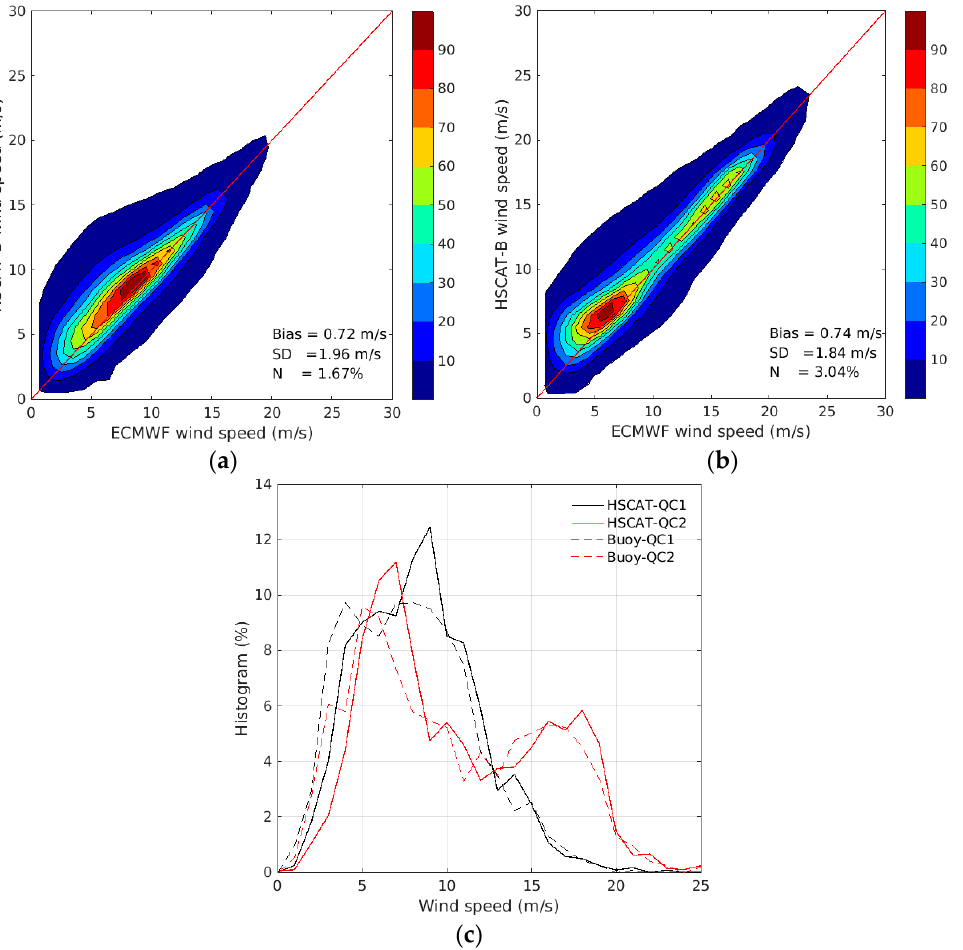
Figure 6. 2-D histograms of HSCAT-B winds rejected by the MLE m QC but preserved by the MLE QC (i.e., QC1) ( a ), and those rejected by the MLE QC but preserved by the MLE m QC (i.e., QC2) ( b ). The 1-D histograms of wind speed for categories “QC1” and “QC2” are shown in ( c ). In ( a , b ), the color bars have the same definitions as in Figure 2a.